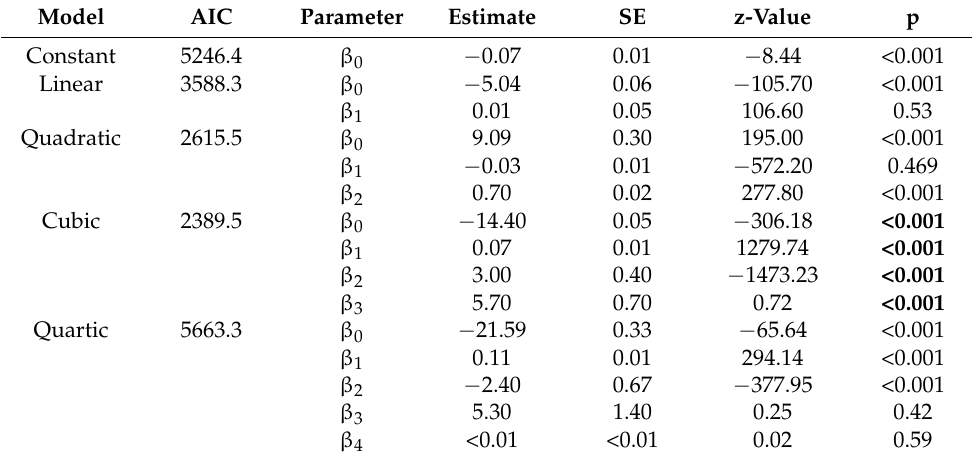
Table 2. GLMM results for the control vs. experimental gillnet comparison. Bold p-values denote the selected model with the lowest AIC and the model parameters resulted in being statistically significant. SE is the standard error of the